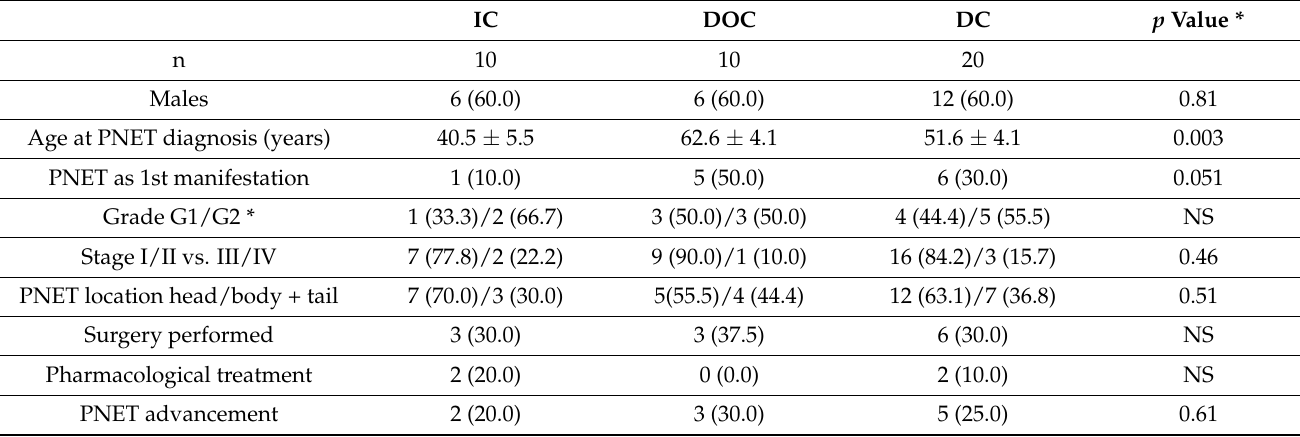
Table 3. VHL-related PNET characteristics–comparison between IC, DC, and